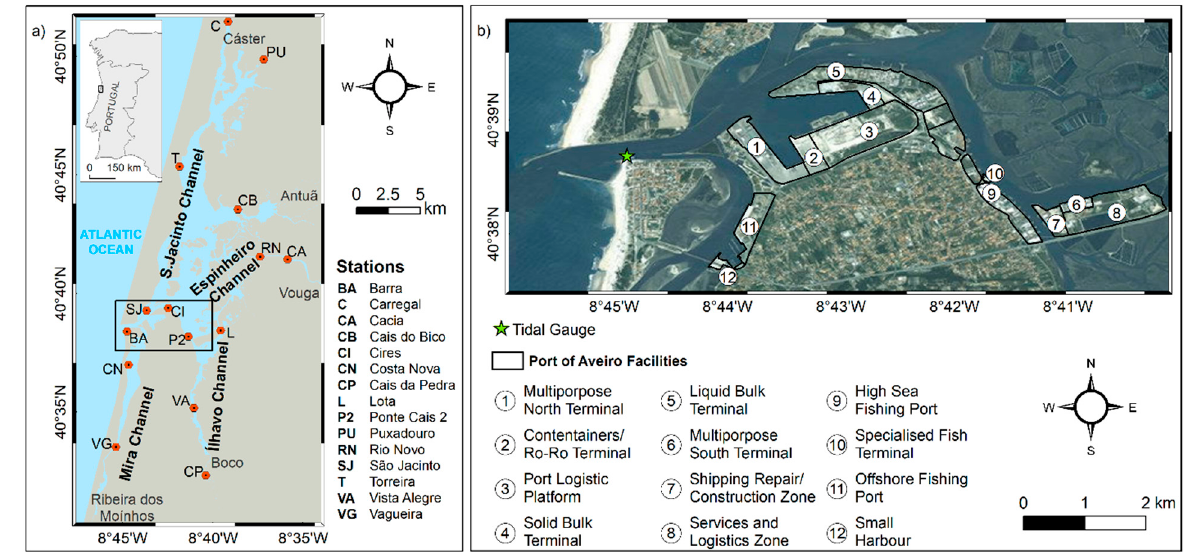
Figure 1. Study area with the in situ stations ( a ) used to validate the hydrodynamic model. Location of the Aveiro Port and the business areas in the port administration jurisdiction ( b ).